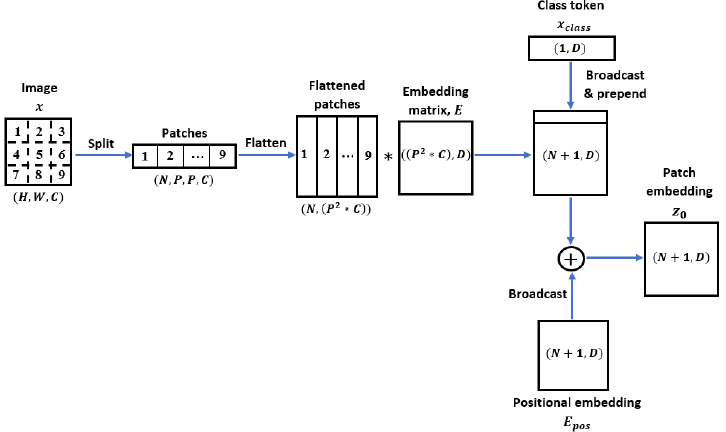
Figure 3. The process flow of patch